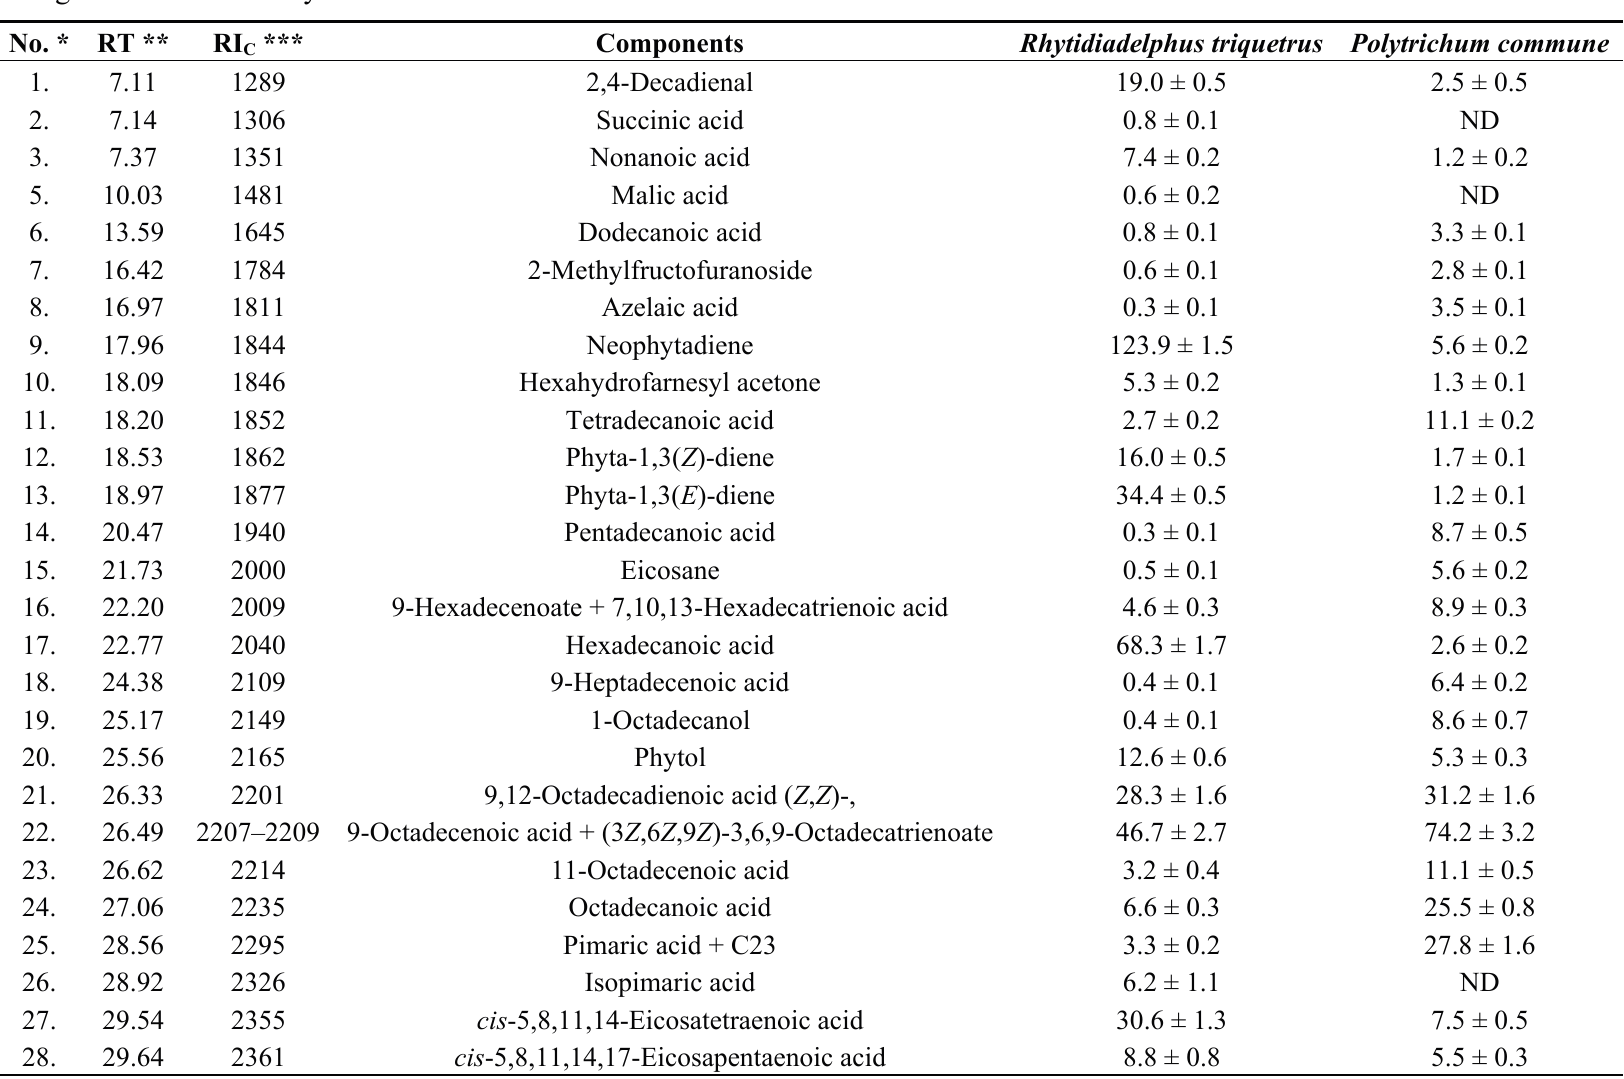
Table 3. Concentrations (mg/100 g dry weight) of substances in the Polytrichum commune and Rhytidiadelphus triquetrus chloroform extracts according to the GC/MS